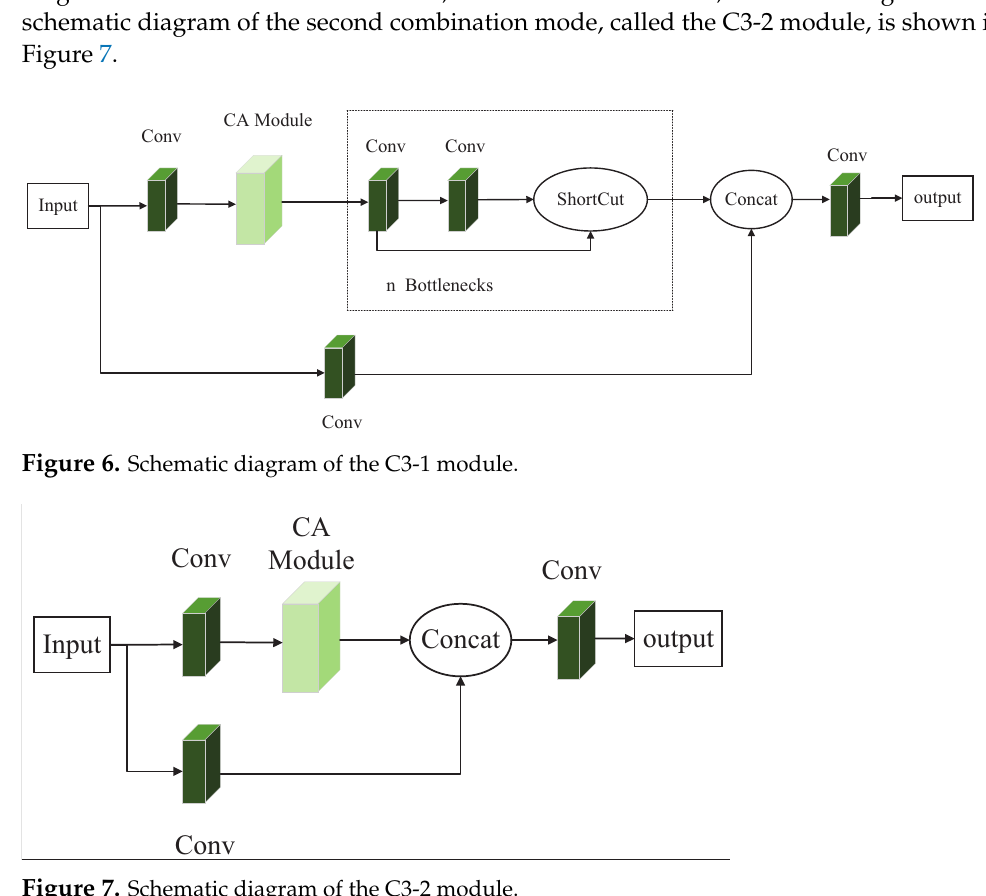
Figure 7. Schematic diagram of the C3-2